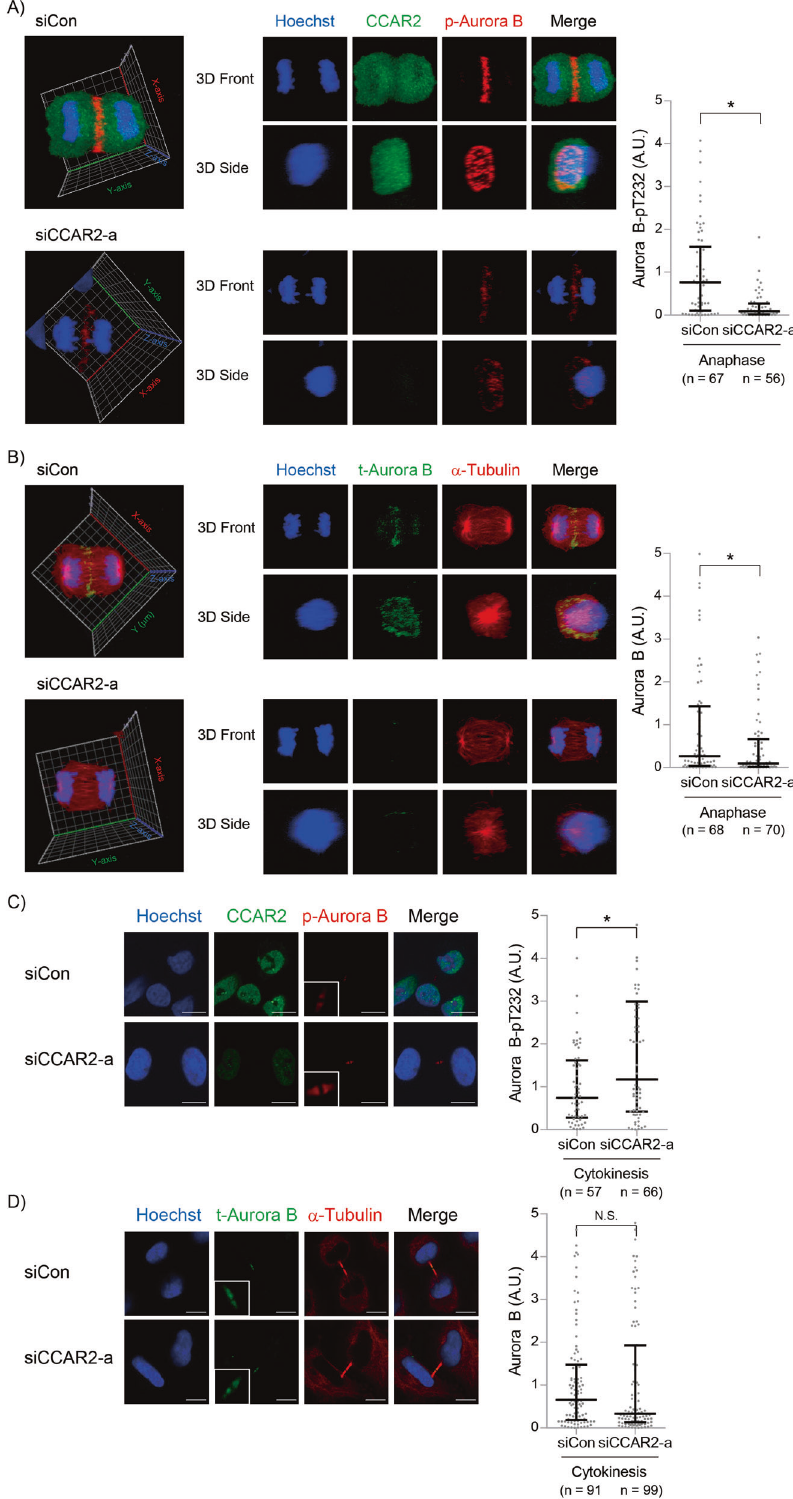
Fig. 7 CCAR2 de fi ciency disrupts the spatiotemporal regulation of Aurora B during late mitosis. Asynchronous cells were stained with Hoechst, and anti-CCAR2, anti-Aurora B-pT232, anti-Aurora B, or anti- α -tubulin antibodies. The levels of Aurora B-pT232 or total Aurora B at the spindle midzone and equatorial cortex during anaphase ( A , B ), and at midbody during cytokinesis ( C , D ), were examined by measuring fl uorescence intensity. The boxes at the corner represent the enlarged midbody. Fluorescence intensity of siCCAR2-a cells was normalized to that of siCon cells at anaphase and cytokinesis. The experiment was repeated independently ( N = 4). The number of anaphase or cytokinesis in all experiments ( n ) was presented in each graph. The fi rst and third bars are the 25th and 75th percentiles, respectively, and the second bar is the median. * p < 0.05, signi fi cantly different from corresponding siCon cells; N.S., not signi fi cant (Mann – Whitney U test); A.U., arbitrary units; each grid, 3 μ m (Fig. 7A, B); scale bar, 10 μ m (Fig. 7C, D). Cell Death and Disease (2022)